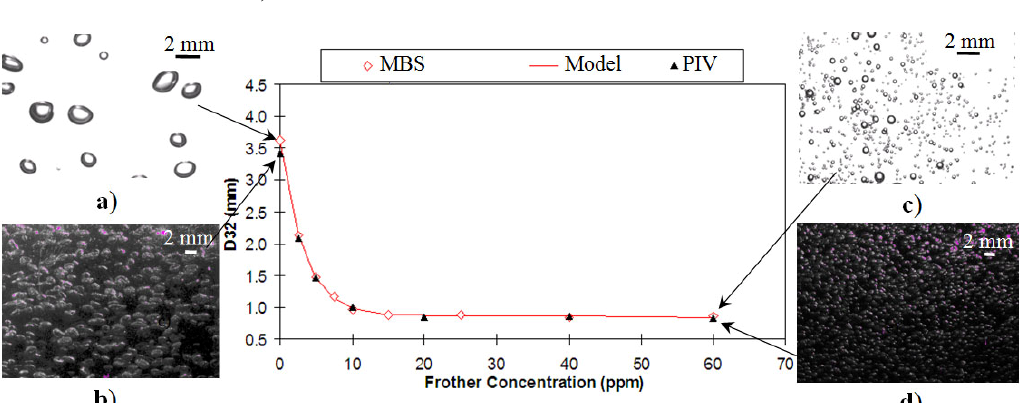
Figure 4. Validation: Sauter mean bubble size as a function of frother DF 250 concentration measured by the MBSA technique (open diamonds) and the particle imaging velocimetry (PIV) technique (closed triangles); ( a ) Example image at 0 ppm concentration by MBSA technique; ( b ) Example image at 0 ppm concentration by PIV technique; ( c ) Example image at 60 ppm concentration by MBSA technique; ( d ) Example image at 60 ppm concentration by PIV technique. (Note, line is the 3-parameter model fit to the MBSA D -C 32